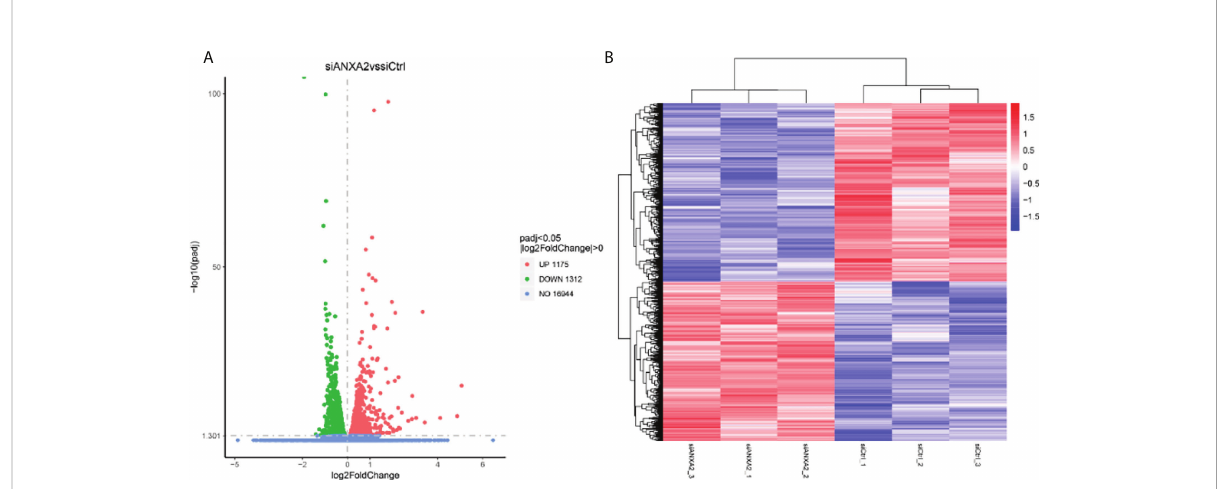
FIGURE 5 Identi fi cation of differentially expressed genes (DEGs) by RNA-seq data analysis between the M. bovis infected-siANXA2 and siCtrl EBL cells. (A) Volcano plots of DEGs expressed between the siANXA2 group and siCtrl group. The blue, red and green dots represent the genes that were not differentially expressed ( p > 0.05), signi fi cantly upregulated, and signi fi cantly downregulated ( p < 0.05), respectively. (B) Heatmap of the DEGs differentially expressed between the siANXA2 group and siCtrl group. Blue-to-red scale indicates low to high DEGs expression levels. The log 2 (FPKM) value is indicated by the gradient color barcode at the right top. Each row corresponds to a gene, and each column corresponds to a